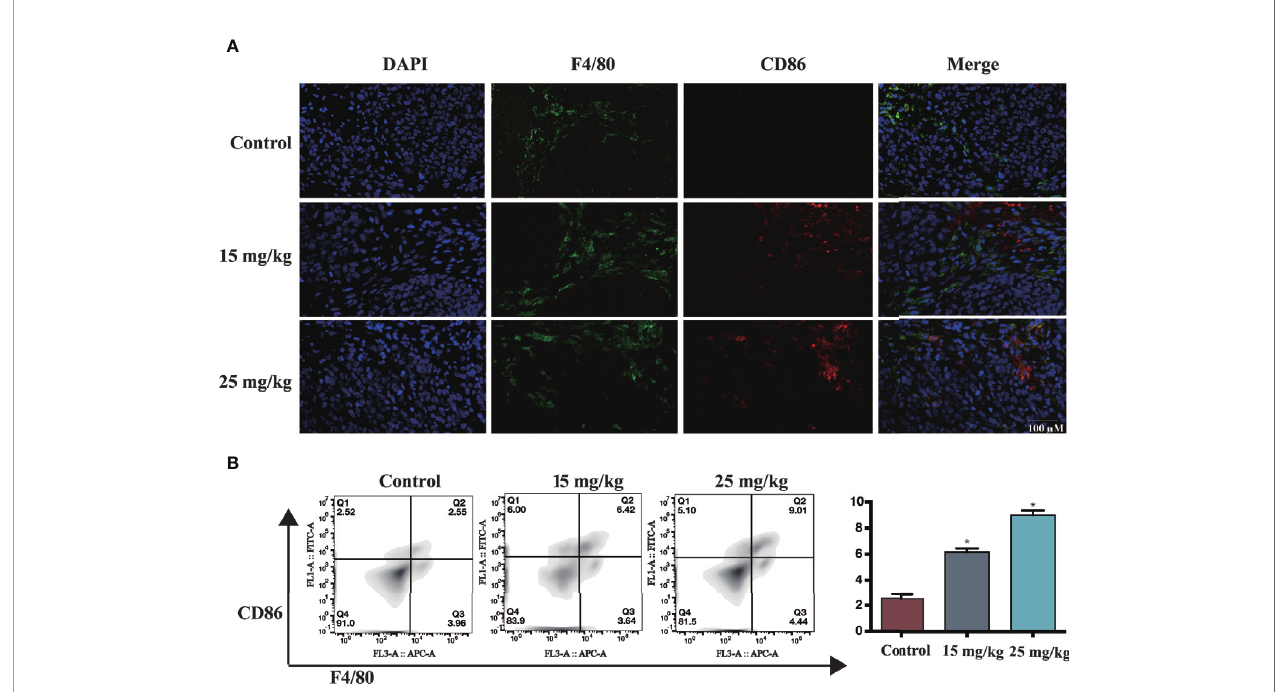
FIGURE 6 | (A) The expression of CD86 and F4/80, determined by IHC. Scale bar: 50 m m (B) Administration of 15 and 25 mg/kg sophoridine increased the expression of the ratio of CD86/F4/80 (n = 3), p < 0.05